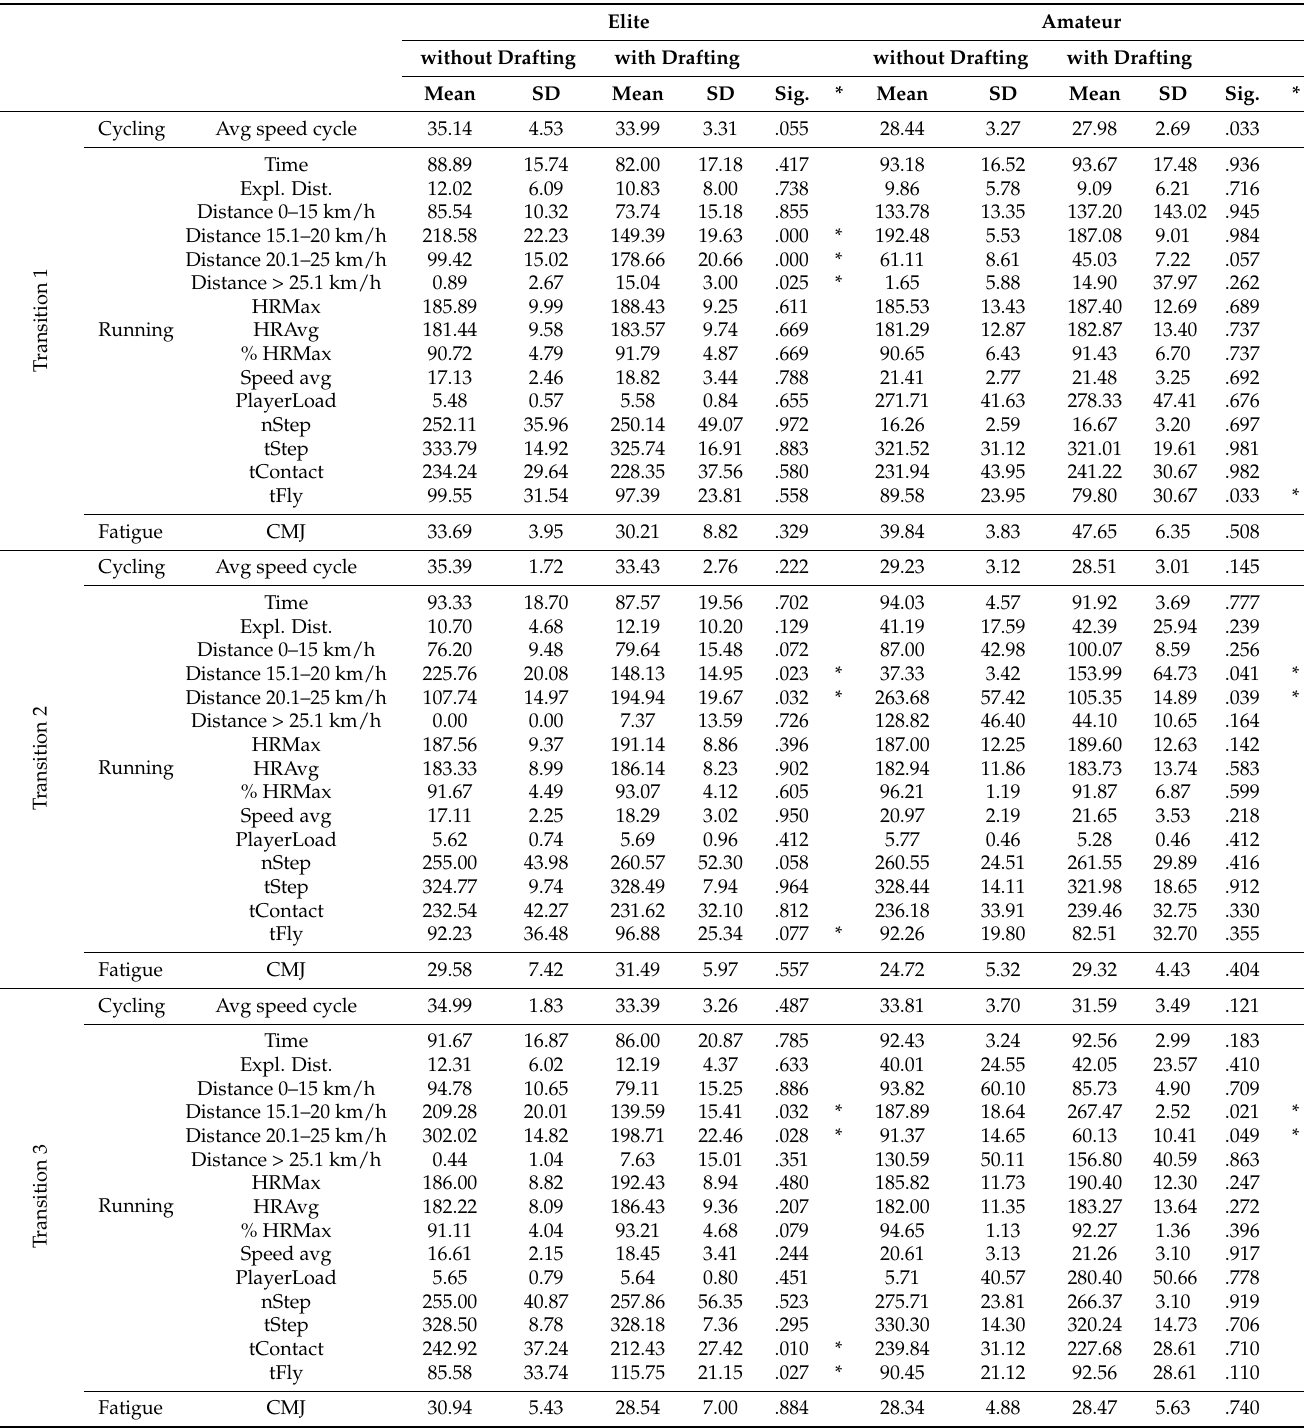
Table 4. Descriptive and inferential results depending on the competitive level and use, or absence, of